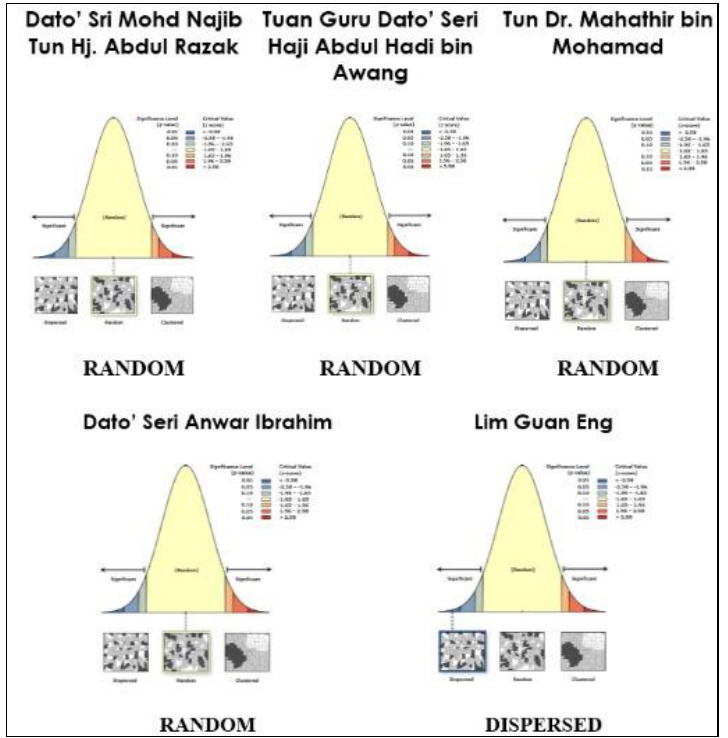
Figure 24. GWR model residuals for assessment to political